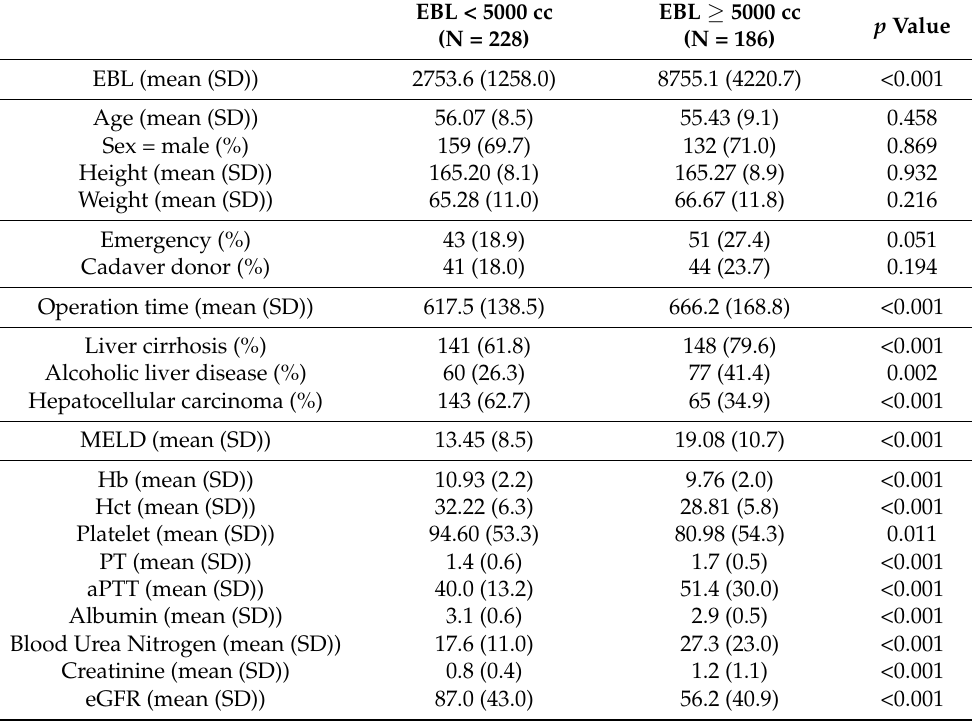
Table 1. Patients’